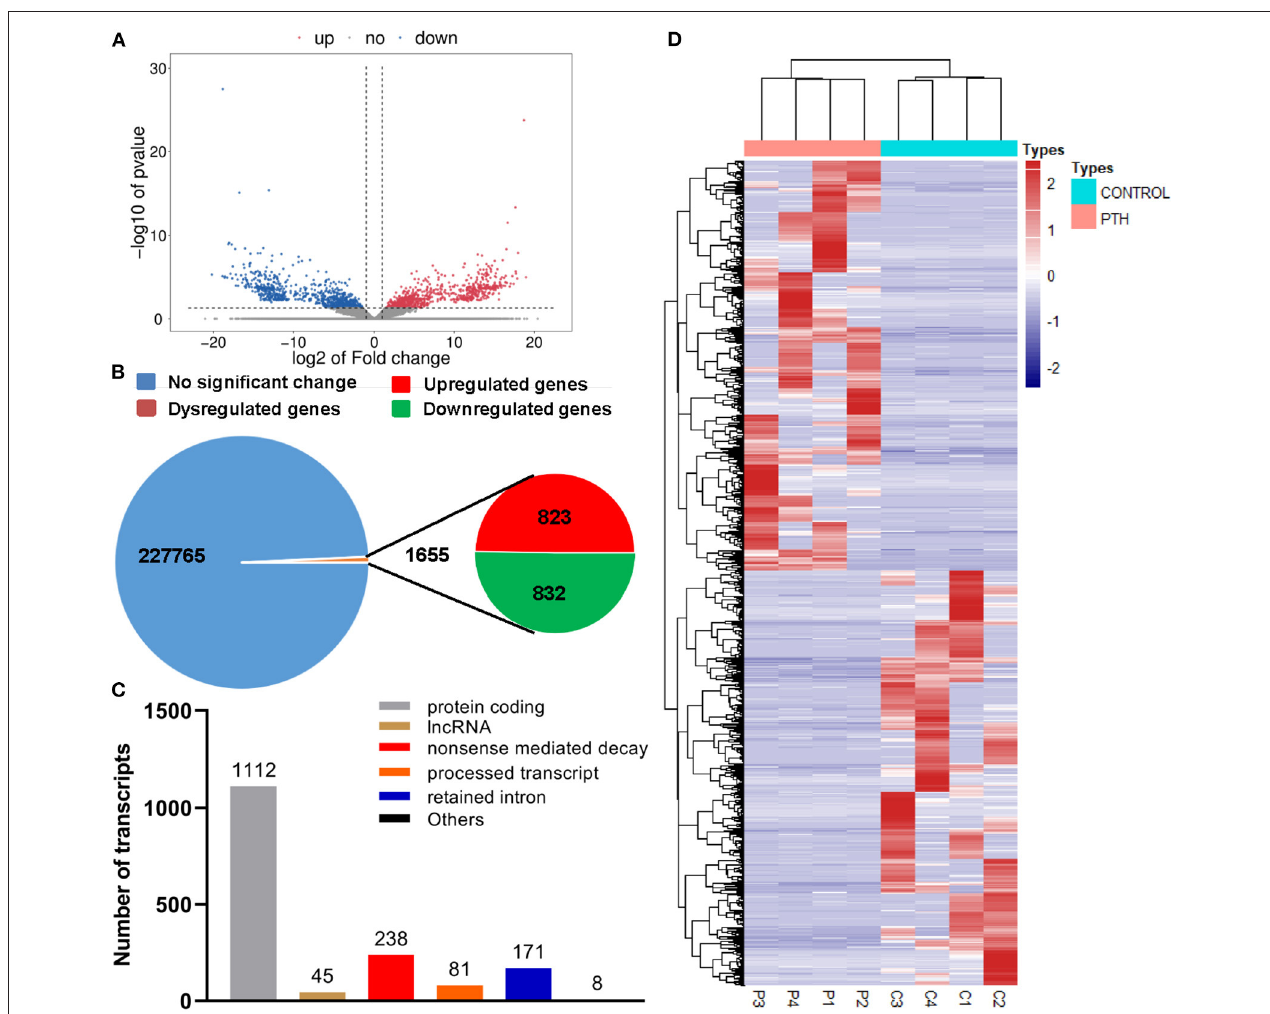
FIGURE 3 | Effect of parathyroid hormone (PTH) on the transcriptome profile of human umbilical vein endothelial cells (HUVECs). (A,B) Volcano plot (A) and statistical graphs (B) of differentially expressed genes (DEGs). (C) Number of differentially expressed transcripts. (D) Heat map of the DEGs. Red represents highly expressed genes; blue, low expression. DEGs were identified with corrected P < 0.05 and absolute fold change ≥ 2. C1-4 represents the control group; P1-4, the PTH-treated (100 pM, 24h) group.